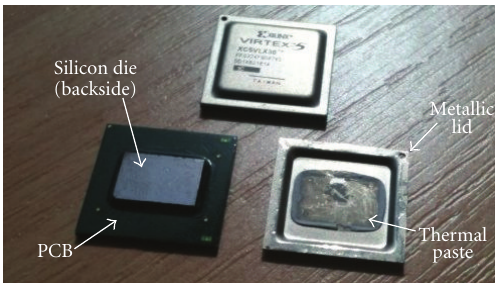
Figure 5: Photograph of the FPGA chip whose cryptographic mod- ules are to be located by cross-correlation